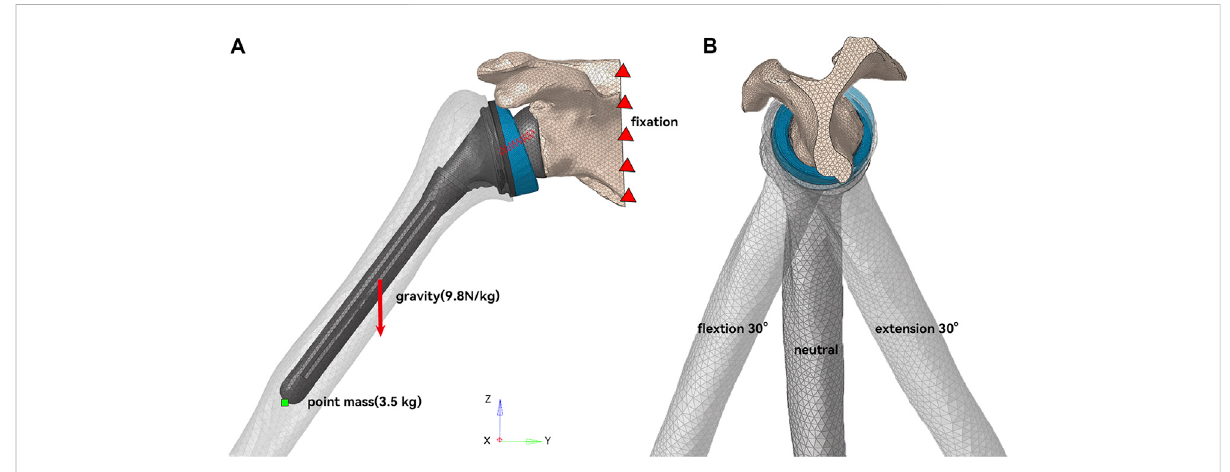
FIGURE 4 Schematic diagram of model working condition setting. (A) In the coronal plane, the humerus was initially abducted at 40 ° . (B) In the sagittal plane, the humerus had three initial postures of neutral, 30 ° fl exion, and 30 °